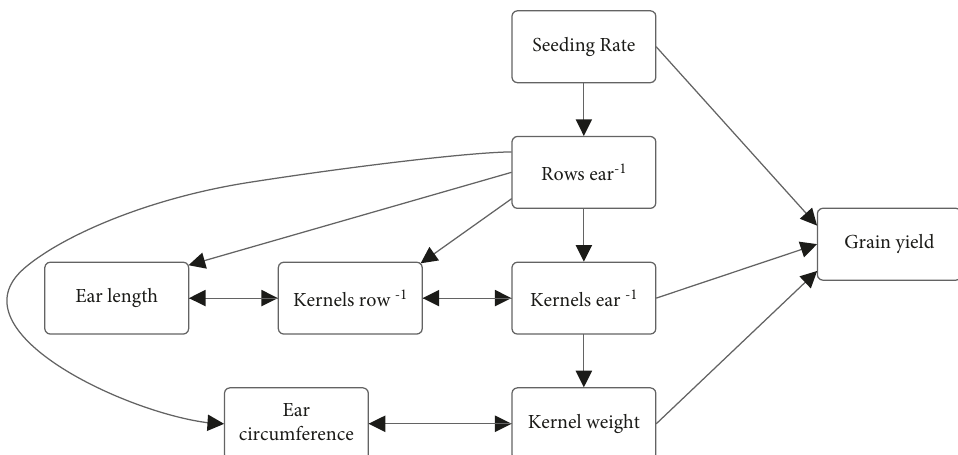
Figure 1: The proposed causal model for a maize yield component study published in Maydica by Milander et al. [1].